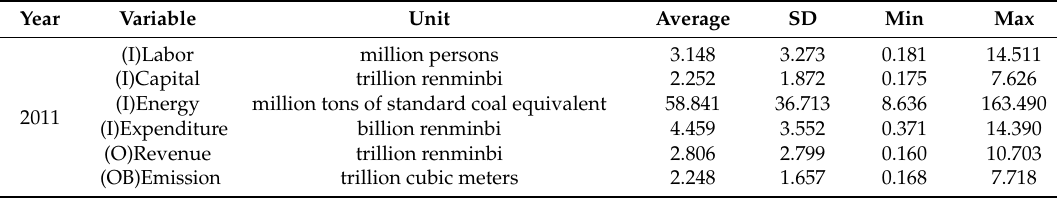
Table 1. Descriptive statistics of inputs and outputs.